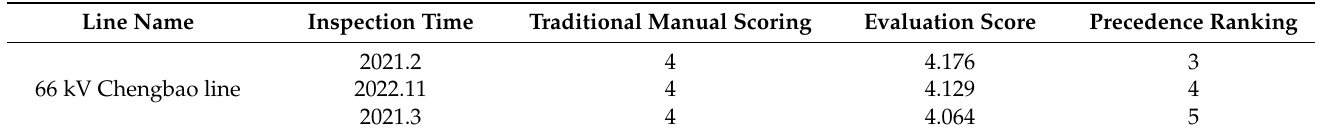
Table 13. Order of transmission lines’ operating status in the Baicheng